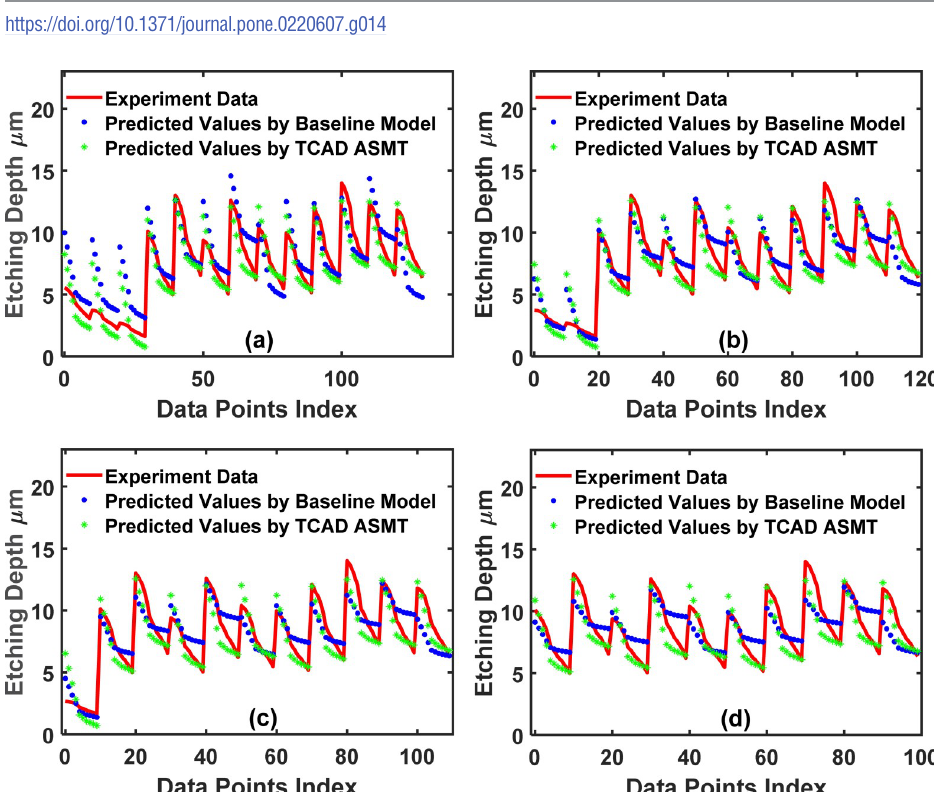
Fig 15. Comparison between the test set prediction using the baseline conventional NN and the TCAD-labeled ASMT algorithm for the 5-input dataset. (a), (b), (c) and (d) show the predicted values for the partition values, 10, 20, 30 and 40,